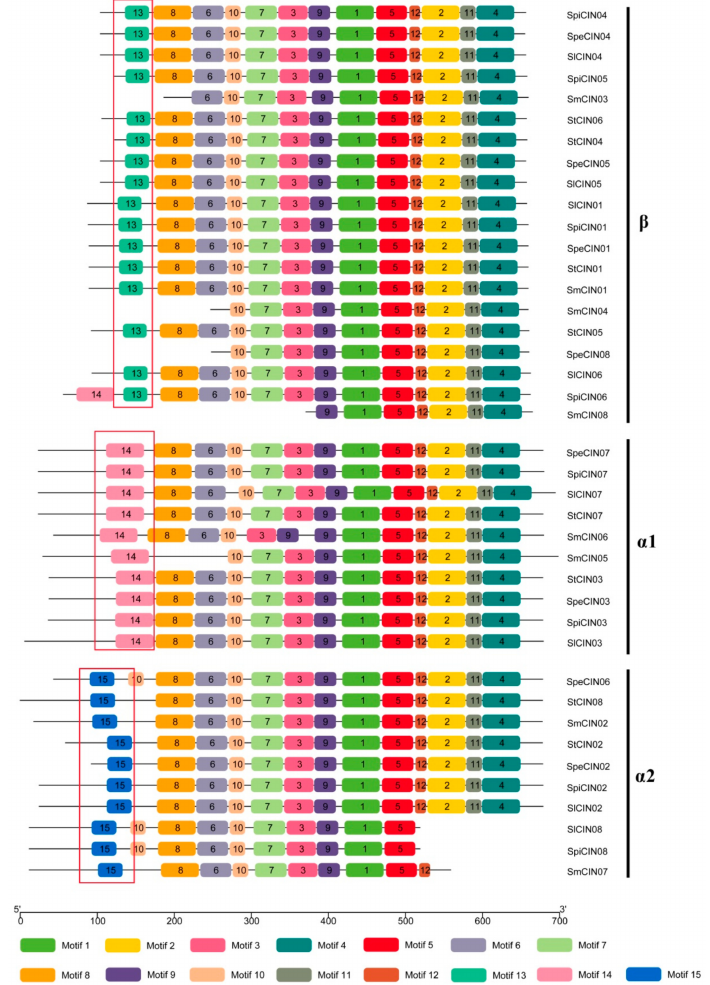
Figure 4. Conserved motifs of 40 CIN proteins. Seven CIN genes ( SmCIN 03 / 04 / 07 / 08, SpeCIN 08 SlCIN 08, SpiCIN 08) are missing some conserved motifs in the N- or C- terminus due to containing shorter amino acids. Di ff erently colored boxes represent di ff erent types of motifs. Specific motifs in β , α 1, and α 2 subgroups are labeled with red